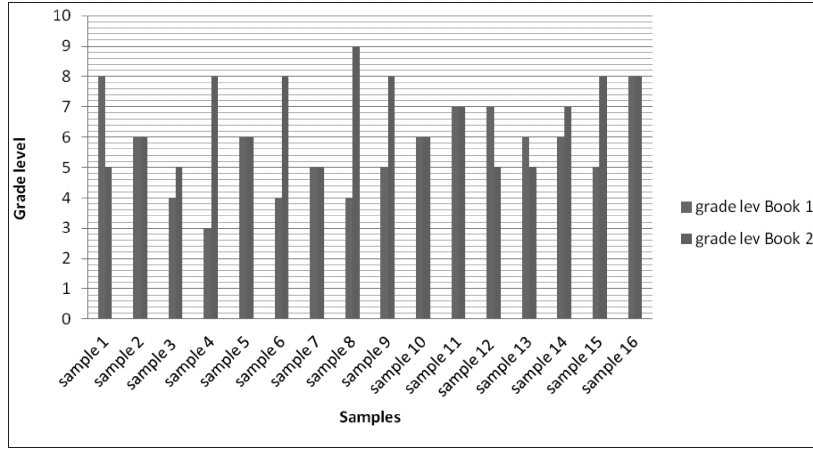
Figure 14: The readability grade levels of the samples from the two textbooks